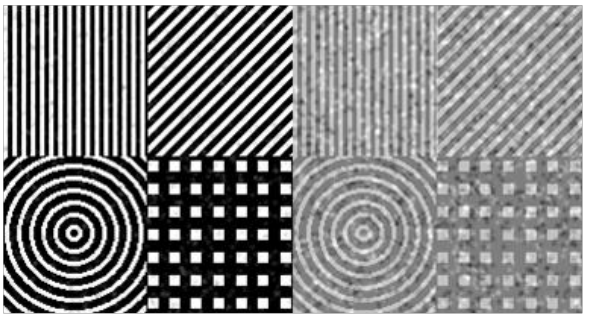
Figure 5. An artificial detailed test image affected with simulated